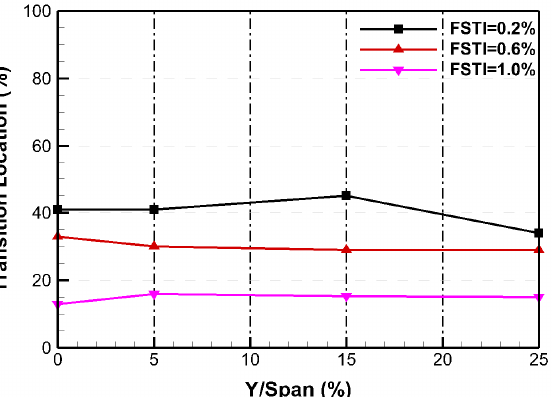
Figure 11. Comparison of the transition location of the central experiment wing with different free stream turbulence intensity.